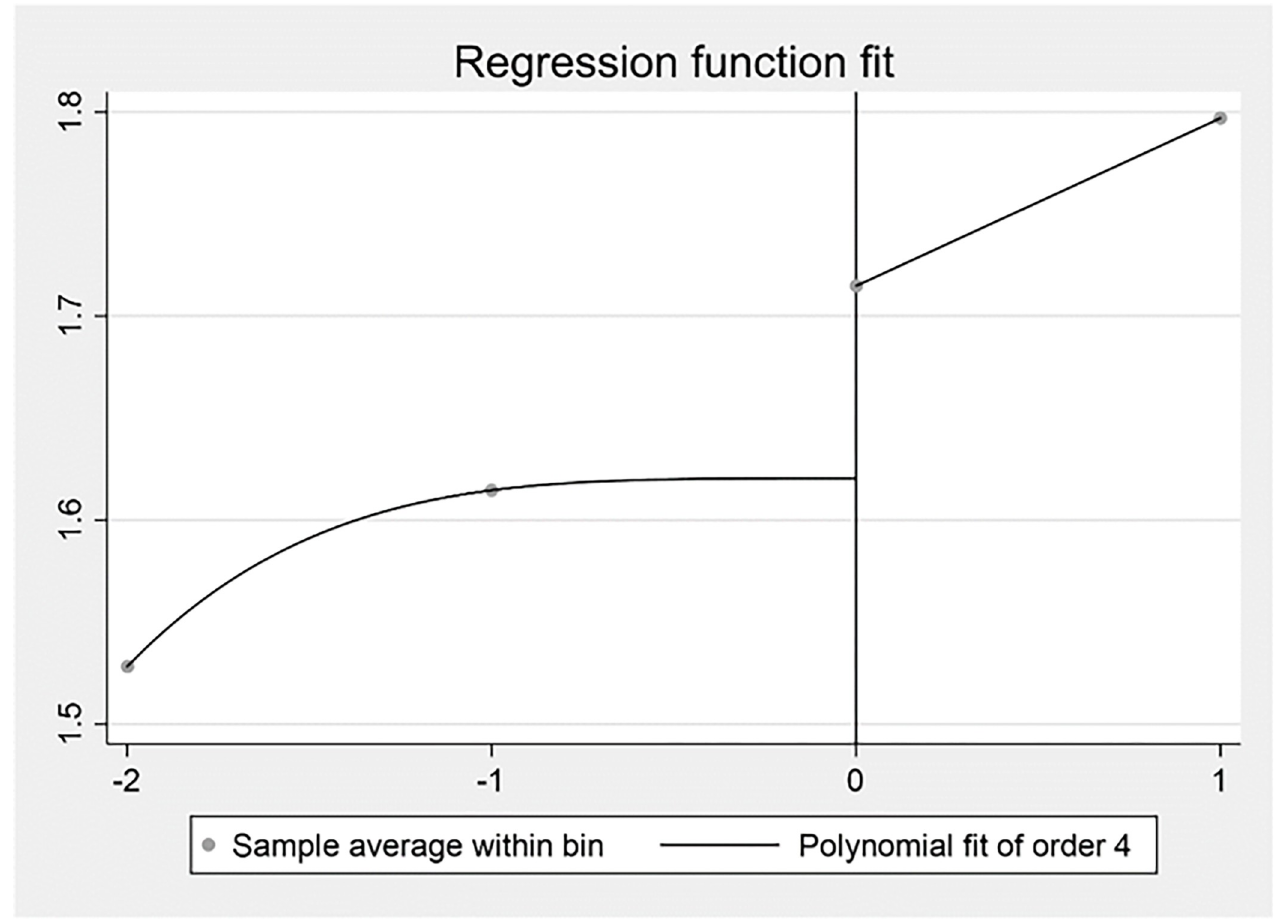
Fig 8. The COVID-19 pandemic and digital